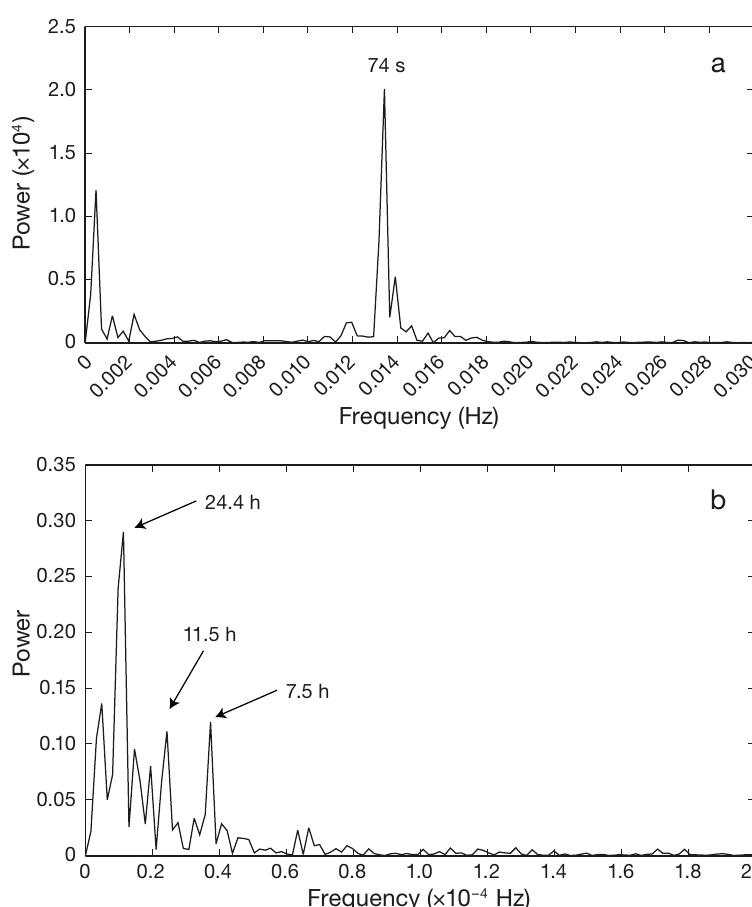
Fig. 2. (a) The power spectra of the x -directional component of the locomotion vector x t , which was obtained by integrating the observed velocities over 1 h between 23:30 and 00:30 h. Two significant peaks appear in the frequency spectrum; the higher-frequency peak (0.0134 Hz) corresponds to a periodicity of 74 s, while the other frequency peak (0.0008 Hz) is thought to be the domi- nant frequency contributing to drift. (b) The power spectra of the ocean cur- rent at a depth of 12 m within the net cage. Significant peaks were observed at around 24.4 h and 11.5 h, with smaller significant peaks at 7.5